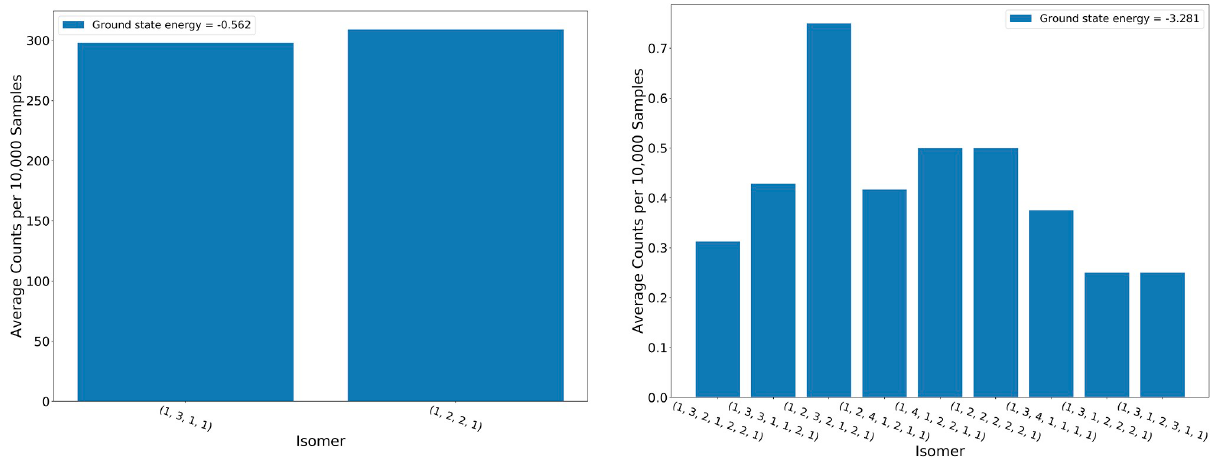
Fig 7. Distribution of returned isomers. Average number of times each isomer was returned per 10,000 samples. Left: Butane ( C 4 H 10 ), Right: Heptane ( C 7 H 16 ).